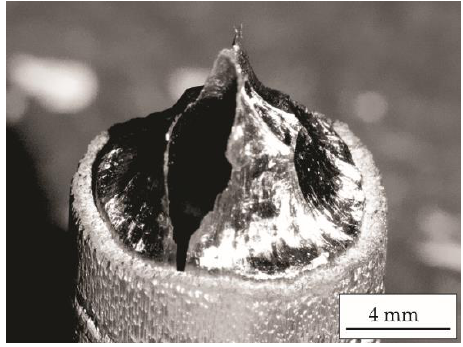
Figure 2. The fracture of strand 2.